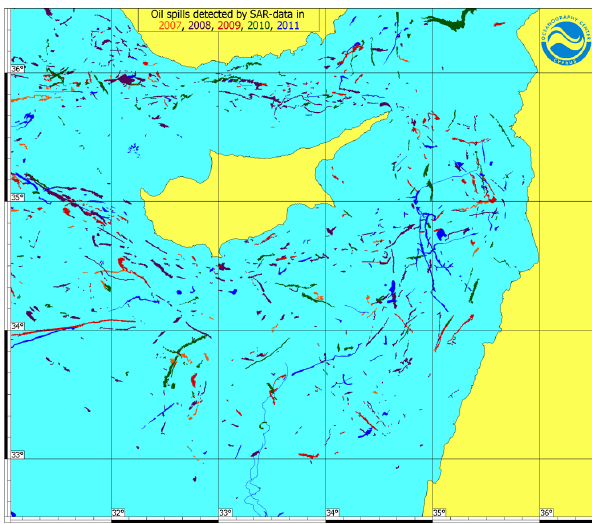
Fig. 1. Composite of all the oil slicks observed in the Eastern Mediterranean Levantine Basin by ASAR imagery during the pe- riod from 2007 to